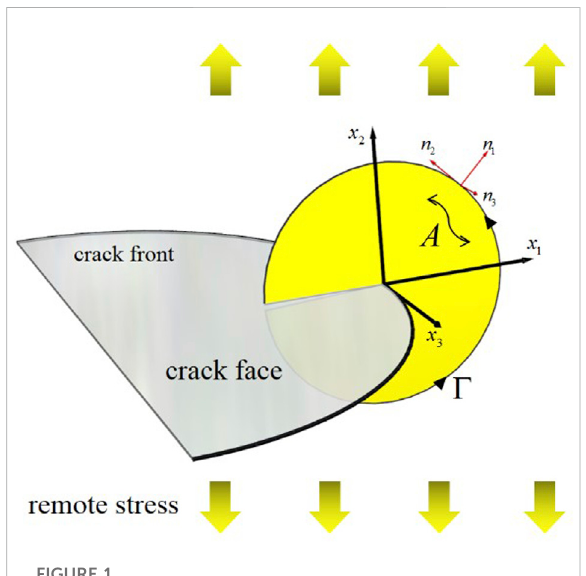
FIGURE 1 Calculation of the pointwise 3D J -integral of the crack